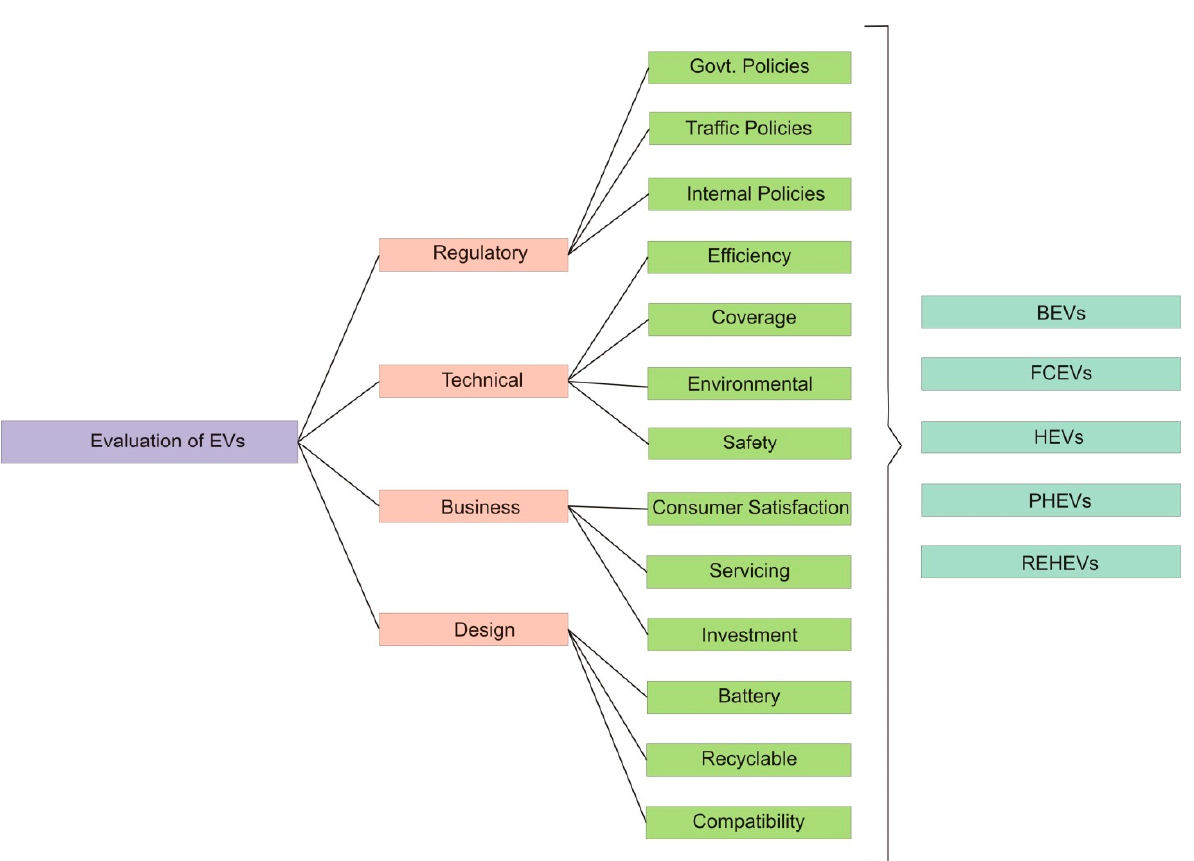
Figure 8. The hierarchy structure for the evaluation of different EVs.